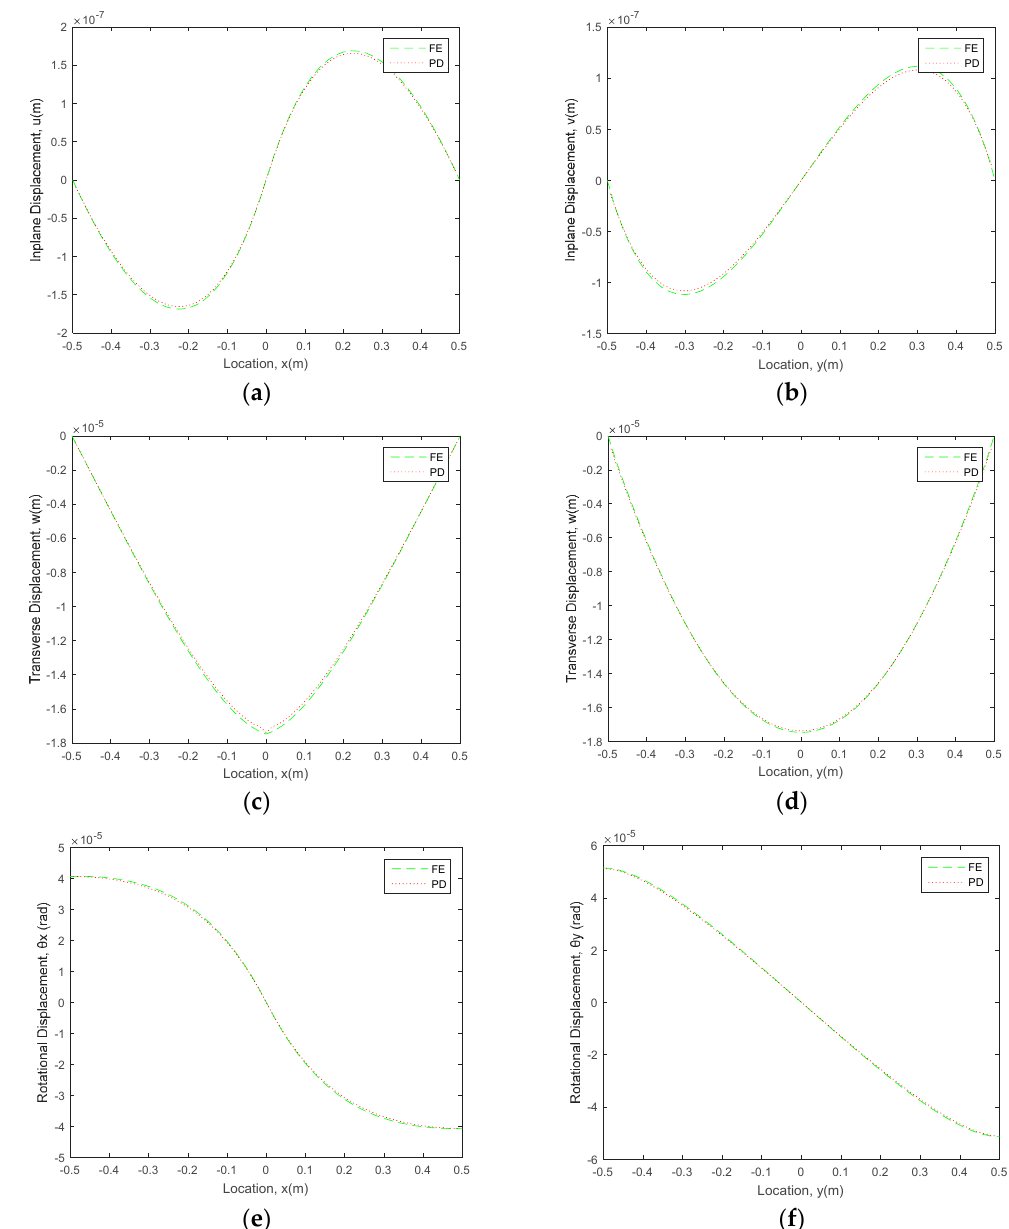
Figure 6. Comparison of PD and FEA results along the central x - and y -axes.